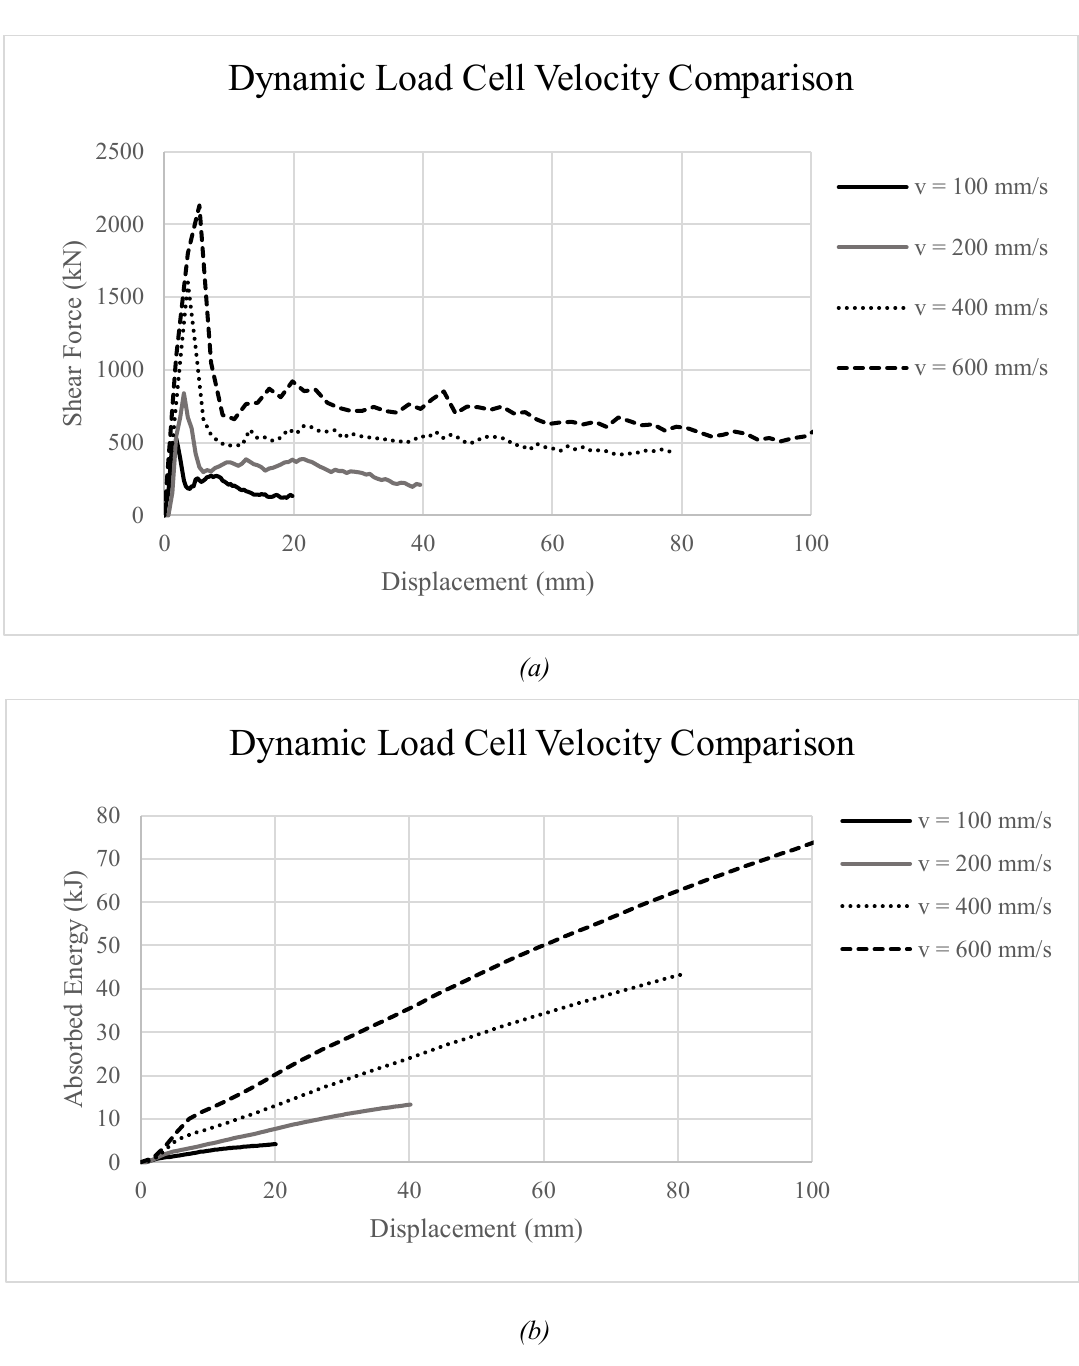
Figure 22. Load cell velocity comparison of ( a ) force vs. displacement and ( b ) absorbed energy vs. displacement.